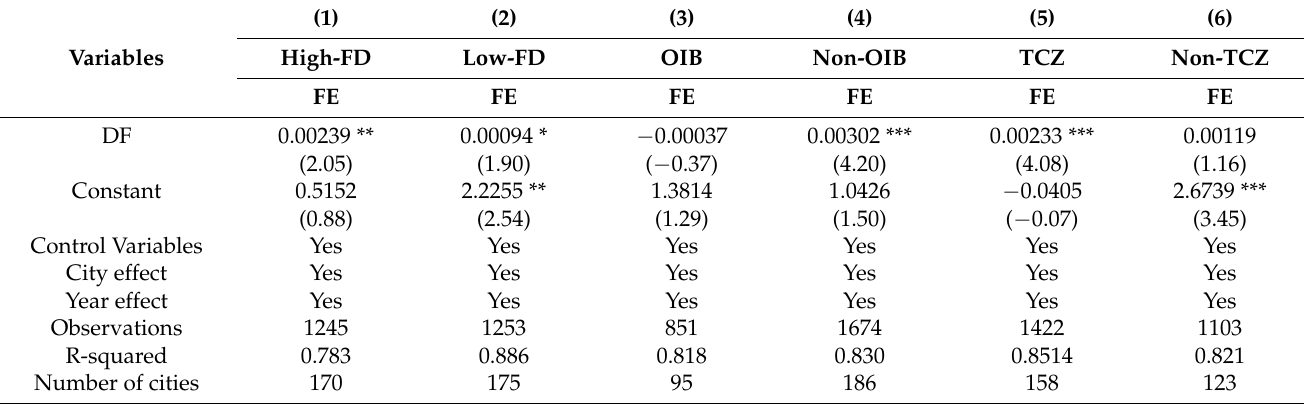
Table 9. Cross-sectional test: environmental regulation, old industry bases, and two-control